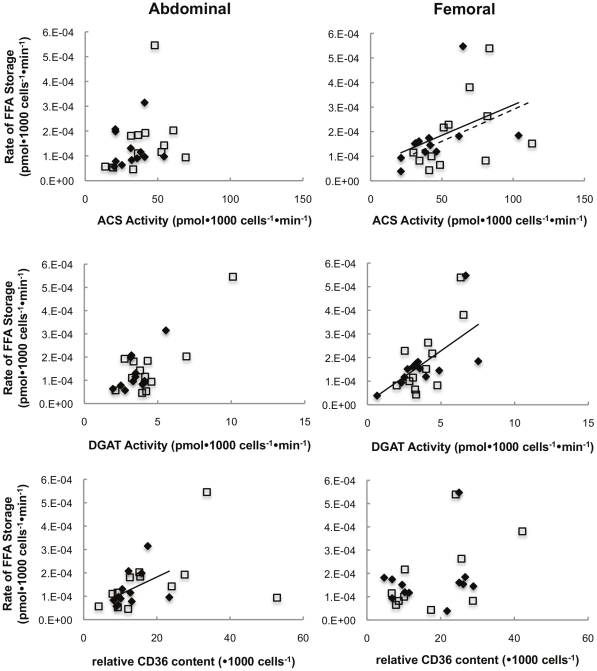
Cellular relationship between regional FA storage factors vs. regional FFA storage.Regional rates of FFA storage (pmol•1000 cells−1•min−1) vs. lipogenic protein activity expressed per 1000 cells. ♦represents T(+) men, □represents T(−) men, —represents a significant correlation in T(+) men, - - -represents a significant correlation in T(−) men.